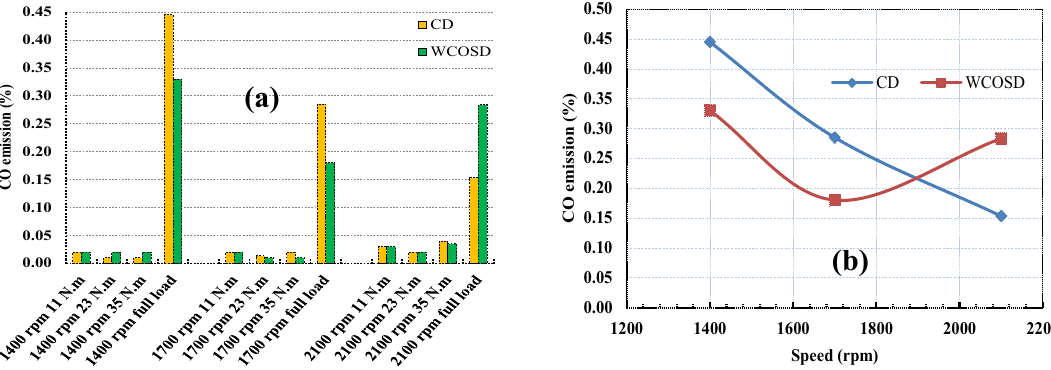
Fig. 7 Carbon monoxide emissions of the test engine fueled CD and WOCSD at a 1400 rpm, 1700 rpm, 2100 rpm and b full